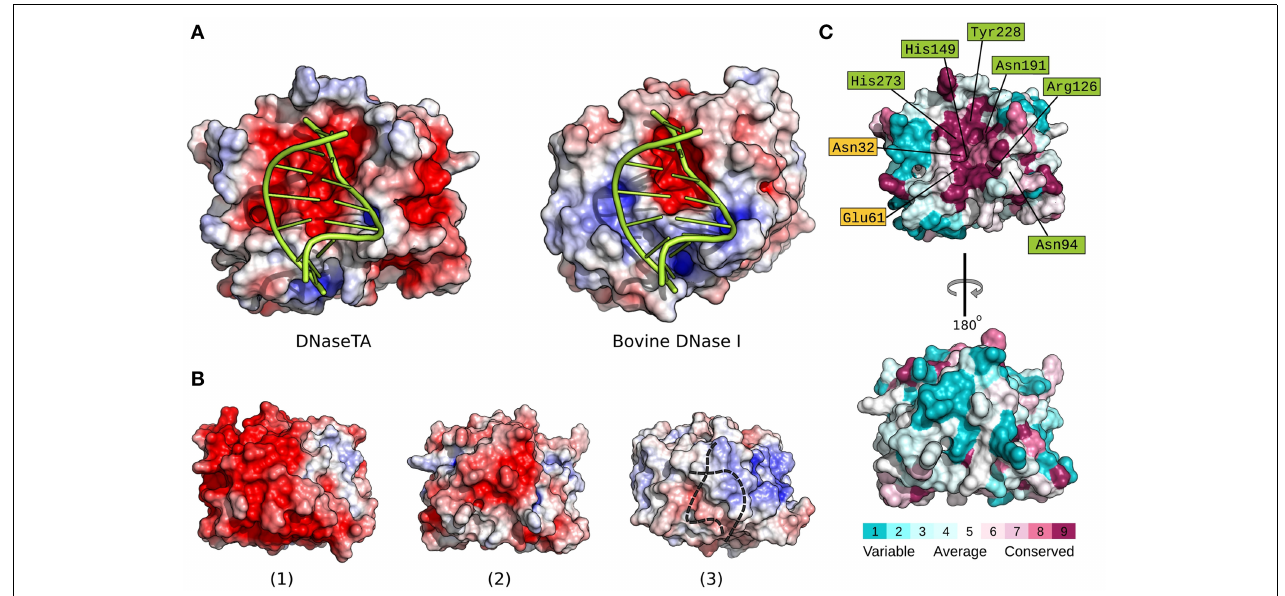
FIGURE 4 | Electrostatic surface potential and evolutionary conserved residue maps. Difference between DNase domain of DNase from Thioalkalivibrio sp. K90mix (DNaseTA) and bovine DNaseI electrostatic potential surfaces, which are in contact with DNA, are depicted in (A) . Here DNA is positioned based on crystallographic bovine DNaseI structure (PDB ID: 1DNK). Electrostatic surface potential maps of DNase domains’ sides which are not facing DNA are depicted